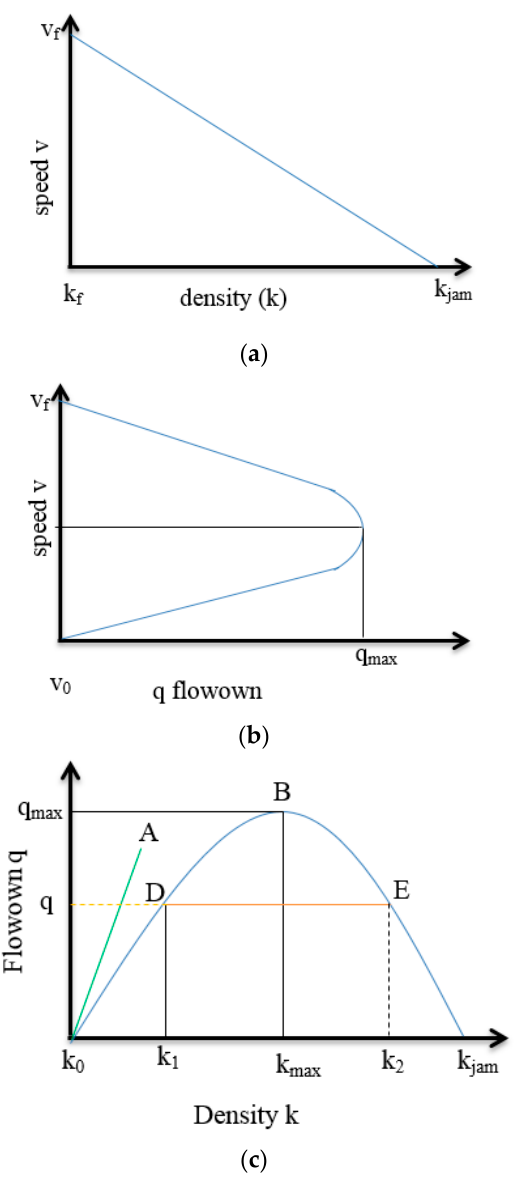
Figure 2. ( a ) Speed vs density; ( b ) speed vs flowown and ( c ) flowown vs density.